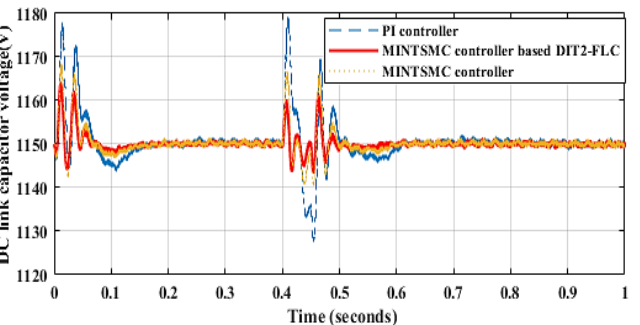
Figure 20. DC link capacitor voltage of the DFIG system under scenario III via the PI controller, MINTSMC controller, MINTSMC controller-based DIT2-FLC.